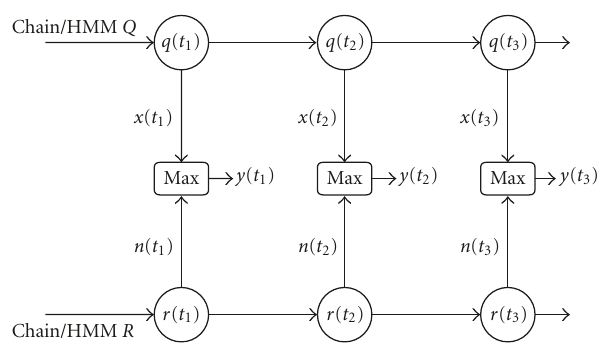
Figure 1: Structure of FHMM composed of two HMMs, Q and R